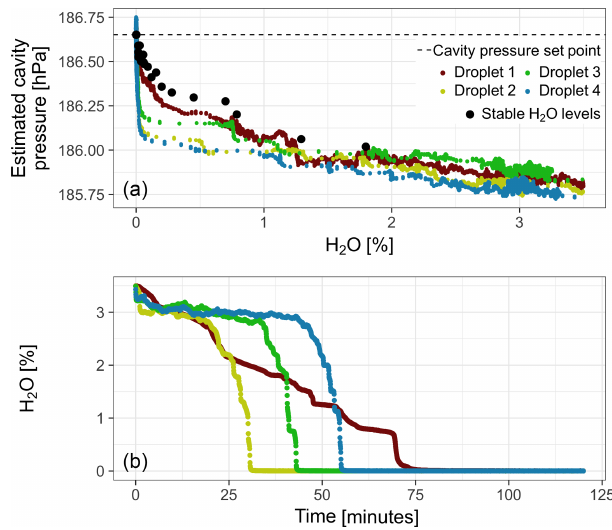
Figure 5. (a) Cavity pressure during droplet experiments with Pi- carro no. 1 estimated based on data from the external pressure sen- sor. For reference, the results from the experiment with stable wa- ter vapor levels from this analyzer are plotted as well (same as in Fig. 4). (b) Temporal progression of water vapor mole fraction dur- ing the droplet experiments after the drop below 3.5% H 2 O.